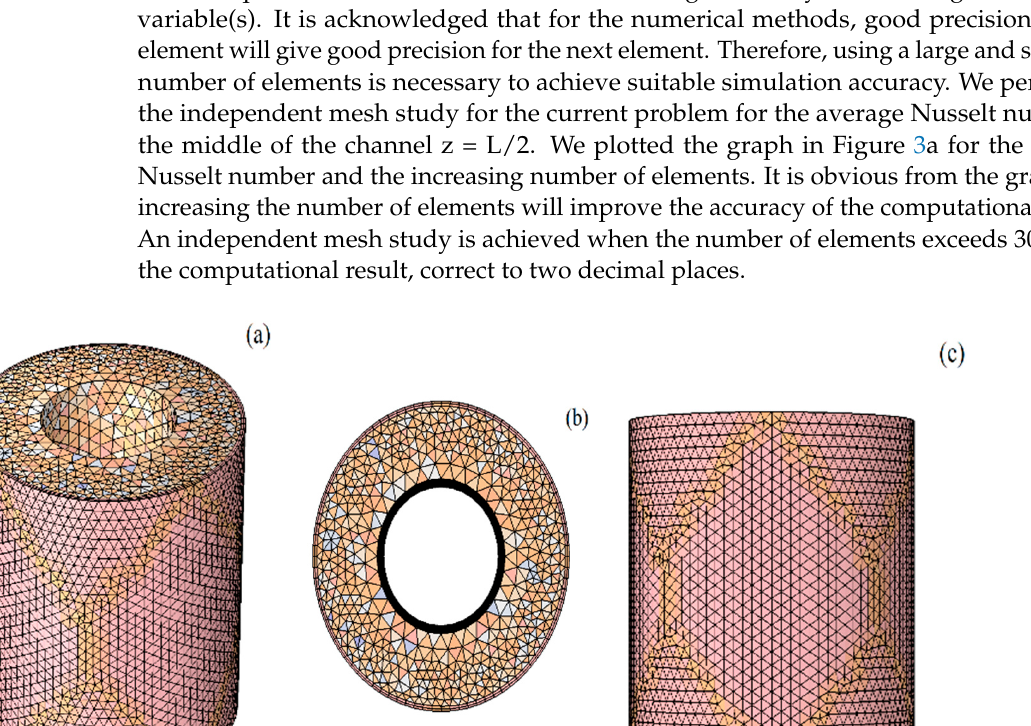
Table 3. Comparison table for the average Nusselt number in inner cylinder with ω = 0.5 and φ =